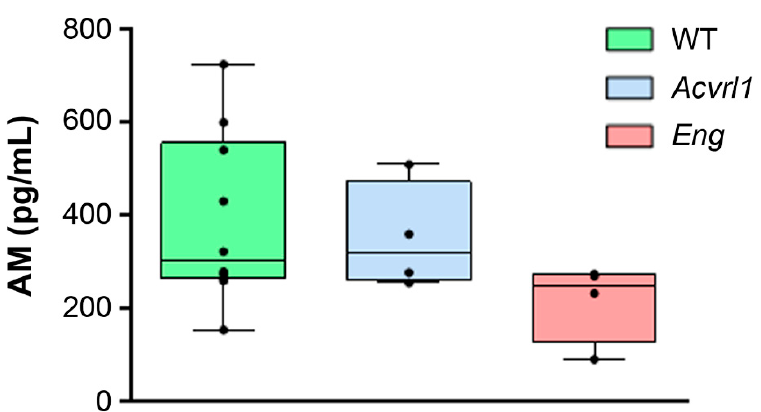
Figure 1. Circulating levels of AM in the serum of mice belonging to the three genotypes measured by EIA. Box plots represent the interquartile range with the median as the horizontal line. Whiskers encompass the maximum and minimum values of the population. Dots represent individual ani ‐ mals.